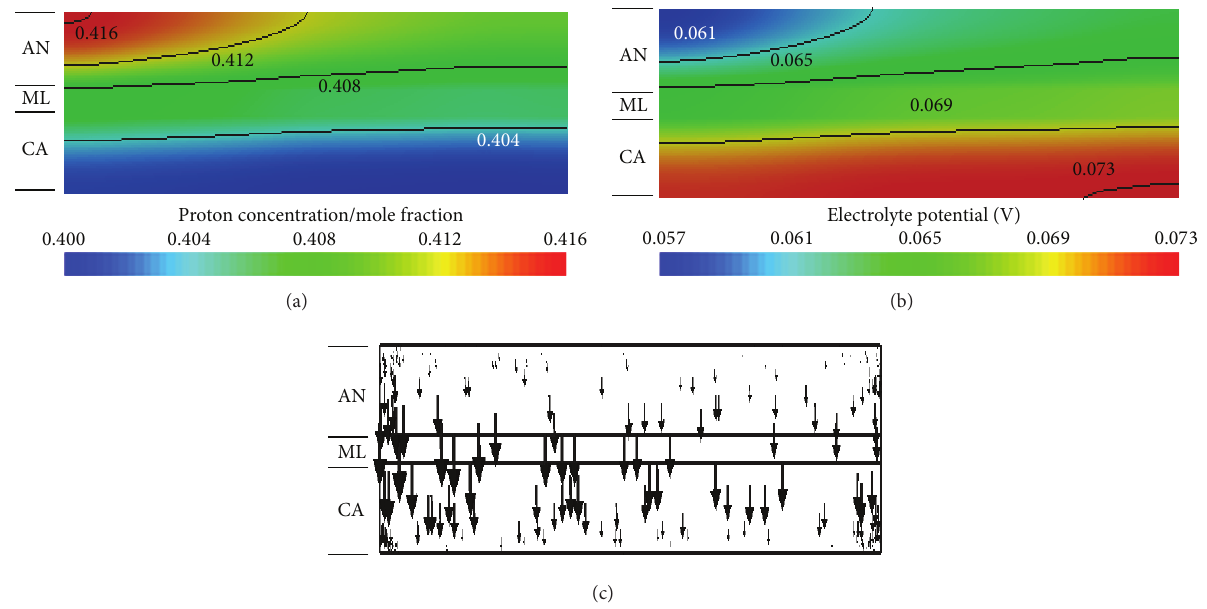
Figure 5: (a) Proton concentration in the electrolyte phase of the anode, membrane, and cathode layers. (b) Electrical potential profile for the electrolyte phase of the anode, membrane, and cathode layers. (c) Protonic flux from anode to cathode in the electrolyte phase. The vectors lengths indicate the flux magnitude which varies from 0 to 17 mAcm −2 in this case.